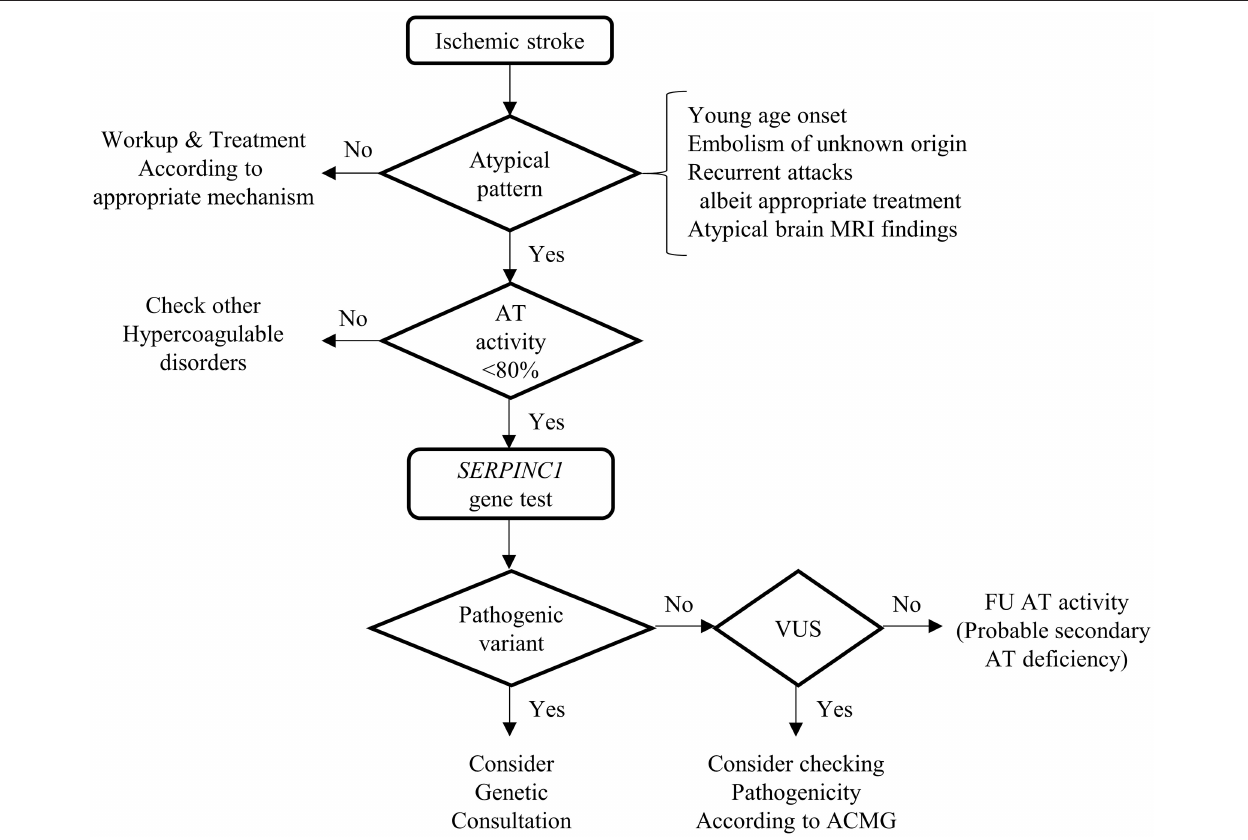
FIGURE 1 | Diagnostic algorithm of SERPINC1 -associated ischemic stroke. This figure shows the diagnostic process of SERPINC1 -associated ischemic stroke. The sequential steps will lead to the detection of the pathogenic variants of the SEPINC1 gene. Because there is the possibility that the variants of uncertain